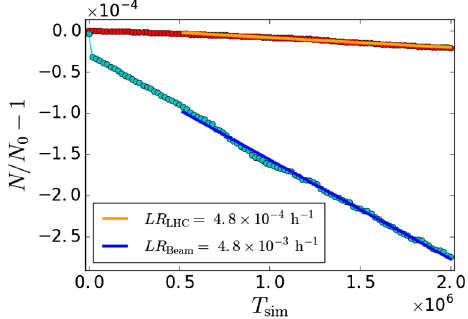
FIG. 5. Example of evolution of bunch intensity, relative to the initial intensity, N 0 . The straight lines represent the linear regressions giving the loss